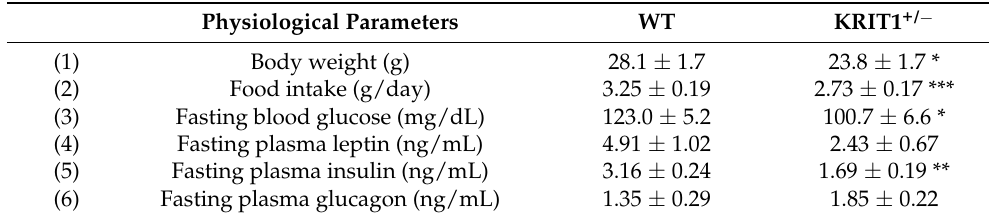
Table 1. Physiological parameters of KRIT1 +/ − mice and WT littermate controls. (1) body weight at 26 weeks of age; (2) average daily food intake during 22 weeks of experimental protocol; (3–6) fasting plasma glucose, leptin, insulin, and glucagon levels at the end of experimental protocol. Data are means ± SEM of 7 mice per group. * p < 0.05; ** p < 0.005; *** p < 0.001 vs. WT. Physiological